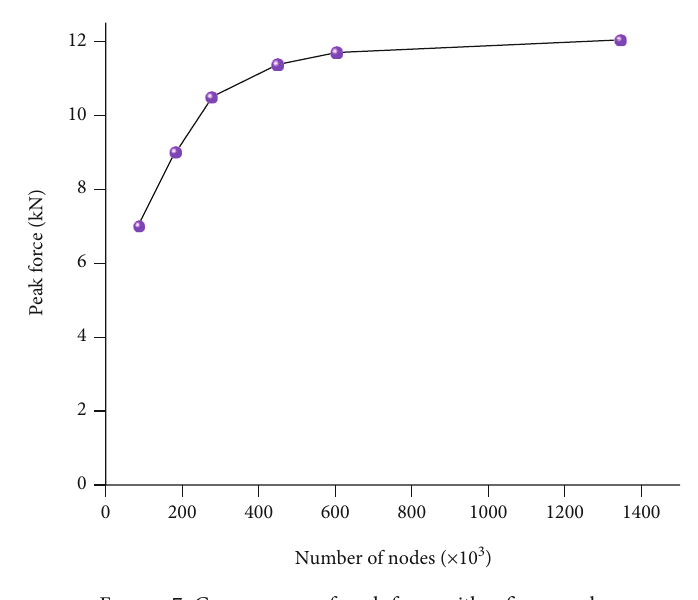
Figure 7: Convergence of peak force with a fi ner